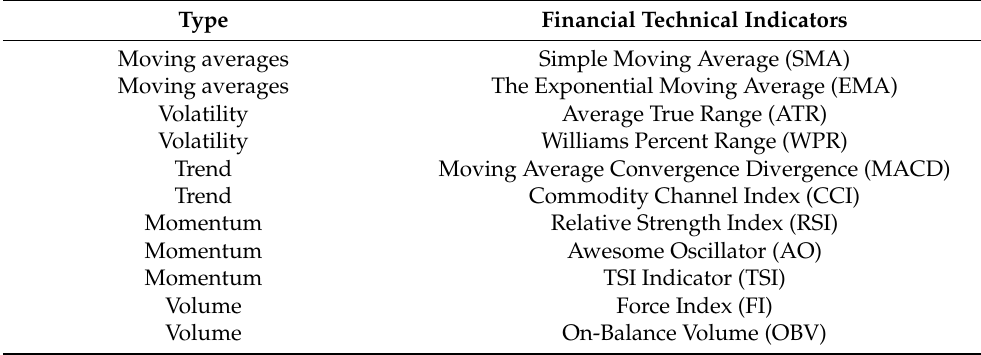
Table 1. Summary of financial technical